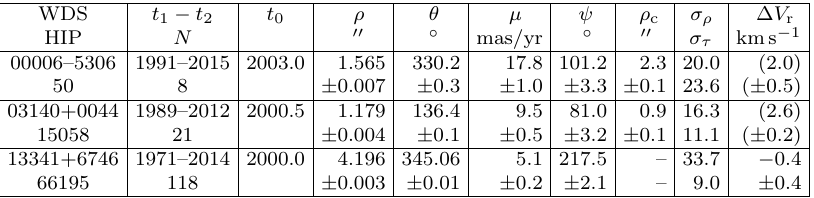
Table 4. Input data: apparent motion parameters and relative radial